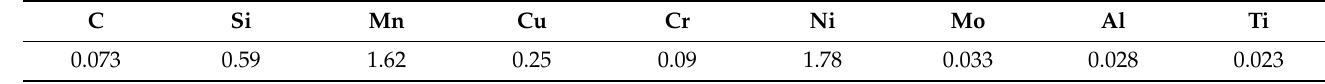
Table 2. Chemical composition of weld wire (wt.%).